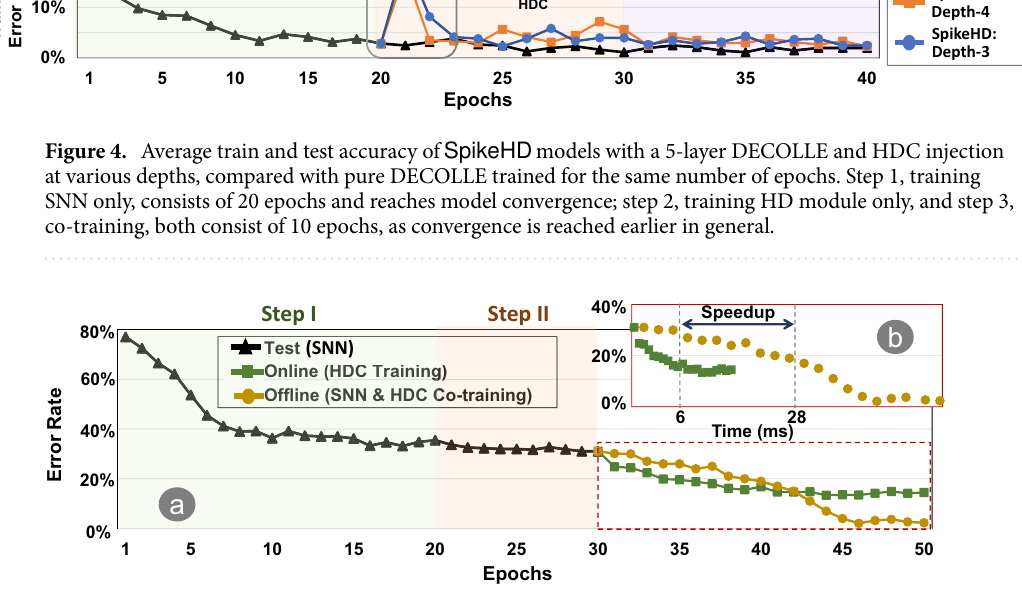
Figure 5. Online and offline training performance by epoch and by running time. ( a ) demonstrates training progress of step I and II with limited training data (100 samples for MNIST). Then, it is trained with the rest of the data either online, where only the HDC part is updated, or offline, where the co-training happens. ( b ) demonstrates the training progress measured by running time, with step II and online/offline step, the former of which is scaled according to training data size for